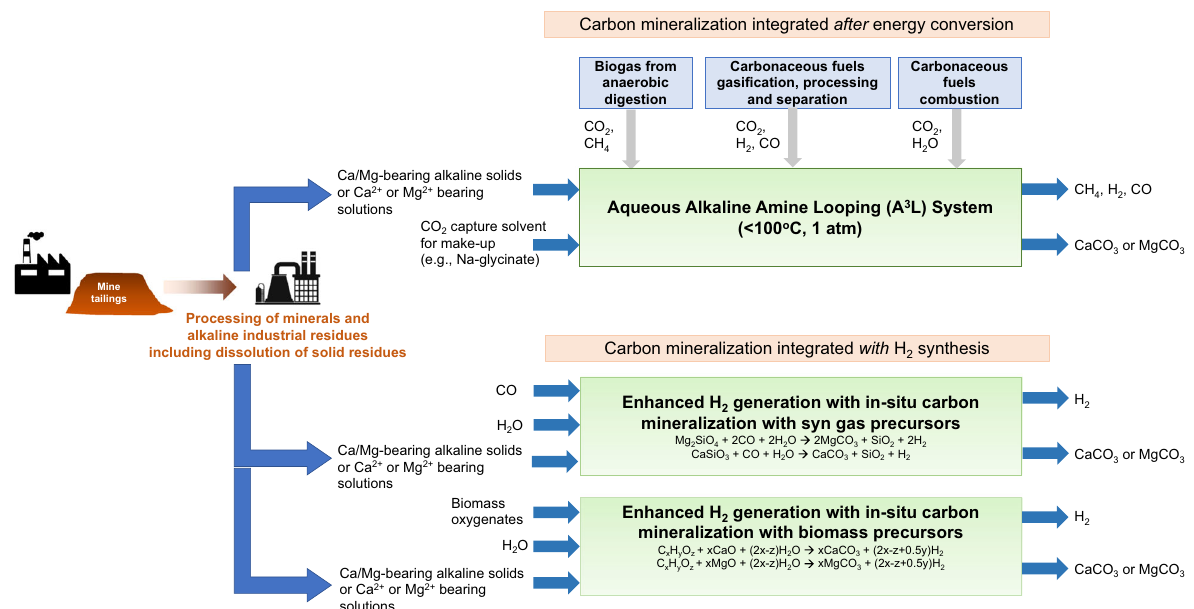
Fig. 1 Schematic representation of the integration of carbon mineralization pathways and energy conversion processes. The aqueous alkaline amine looping reactor captures CO 2 from fl ue gas using aqueous solvents such as amines and amino acid salts, and the high concentrations of carbonate and bicarbonate ions react to produce calcium or magnesium carbonates, with the inherent regeneration of the solvent. This reactor is integrated with various CO 2 emitting energy conversion processes. Carbon mineralization can be integrated with the water – gas-shift reaction or biomass conversions to enhance H 2 formation and remove CO 2 as calcium or magnesium